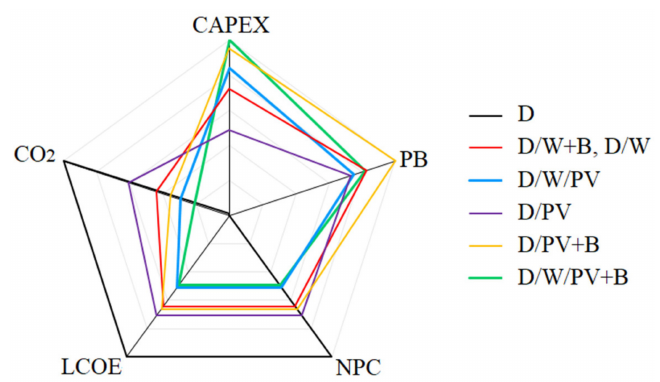
Figure 5. The main performance indicators of various configurations in relative units: CAPEX , PB, NPC , LCOE , and annual carbon dioxide emissions (CO 2